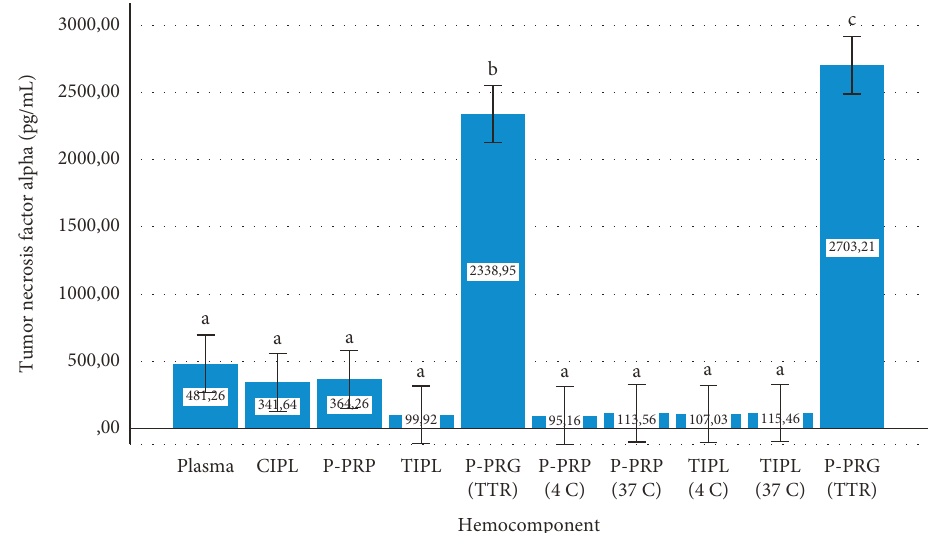
Figure 11: Overall mean ± sd tumor necrosis factor alpha either conserved or released from hemocomponents. a–c Different lowercase letters denote significant ( P < 0 . 001) differences between hemocomponents by the Games–Howell post hoc